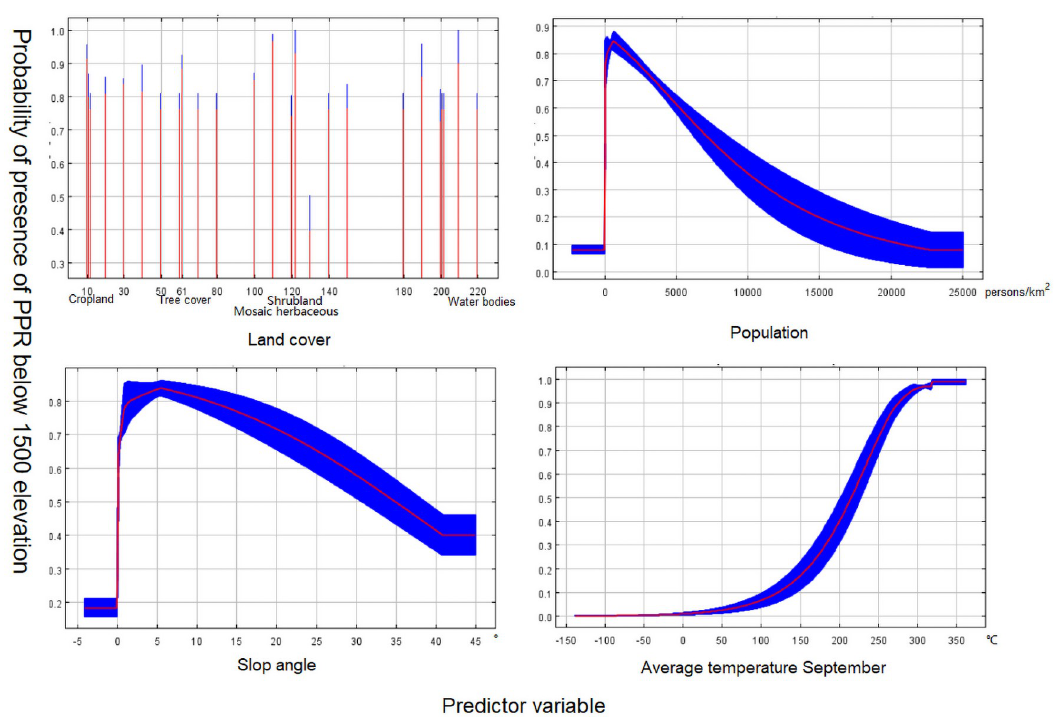
Fig 3. The response curves of the model ( > 1500 m). The curves show the mean response (red) and the mean standard deviation